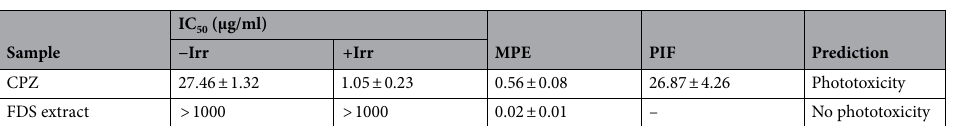
concentration (IC 50 ) of chlorpromazine hydrochloride (CPZ) upon non-UV- and UV-irradiated conditions was accepted, regarding the recommendation of the OECD TG 432 (see Table 3). The IC 50 of CPZ should be in ranges of 7.0–90.0 μg/mL without UV irradiation and 0.1–2.0 μg/mL after UV-irradiated condition. The mean photo effect (MPE) and photo-irritation-factor (PIF) values of CPZ also showed phototoxicity. It suggested that the